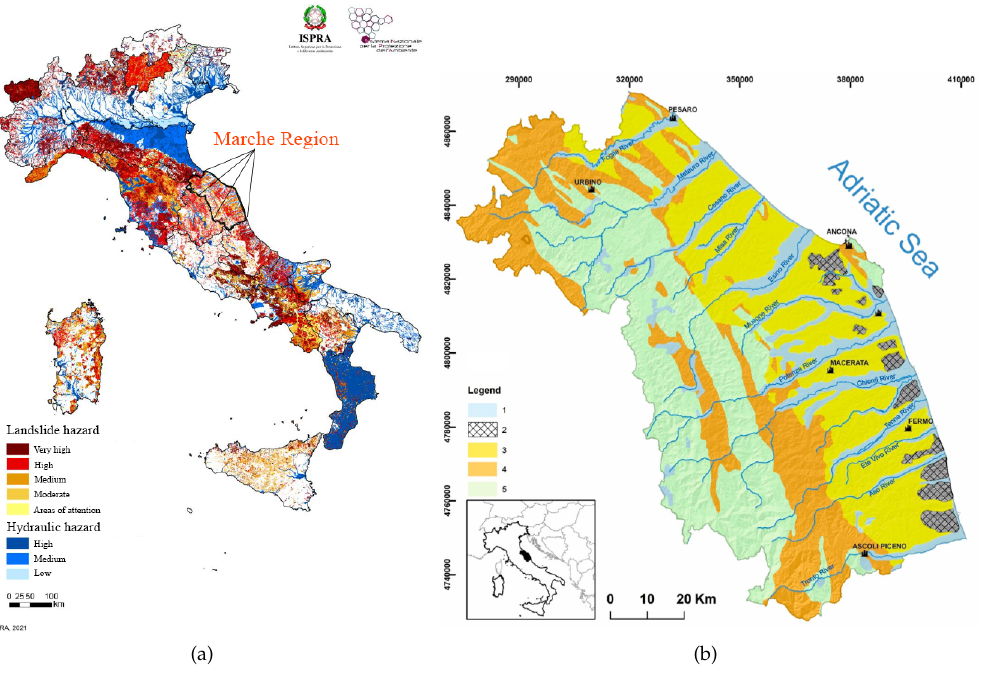
Figure 1. Area subjected to control. ( a ) Map of hydrogeological risk in Italy, referred to the ISPRA report 2021. ( b ) Schematic geological map of the Marche region. (1) Main continental deposits (Pliocene-Pleistocene-Holocene); (2) sands and conglomerates (Pliocene–Pleistocene); (3) clays and sands (Pliocene–Pleistocene); (4) arenaceous-marly clayey turbidites (late Miocene); (5) limestones, marly limestones and marls (early Jurassic–Oligocene)